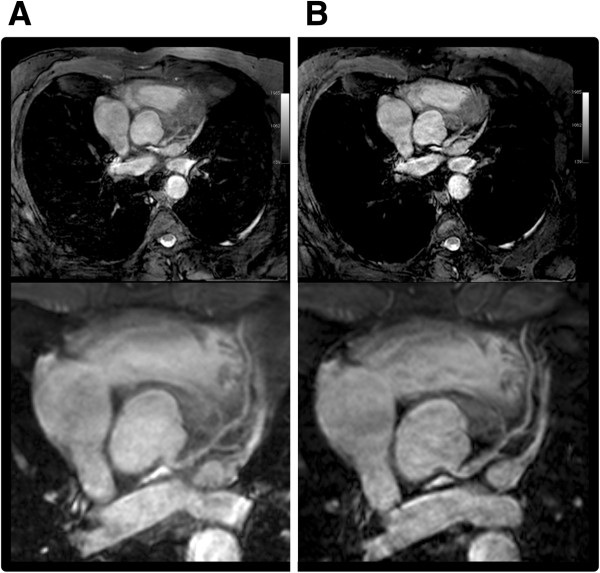
Volume-targeted bSSFP scans of the left anterior descending artery in a healthy volunteer, acquired during free breathing (A) and during one breathhold (B), with the same spatial coverage and resolution. Top: 2D slice from the 3D volume selected for demonstration. Bottom: multi-planar reformatted images of the artery.